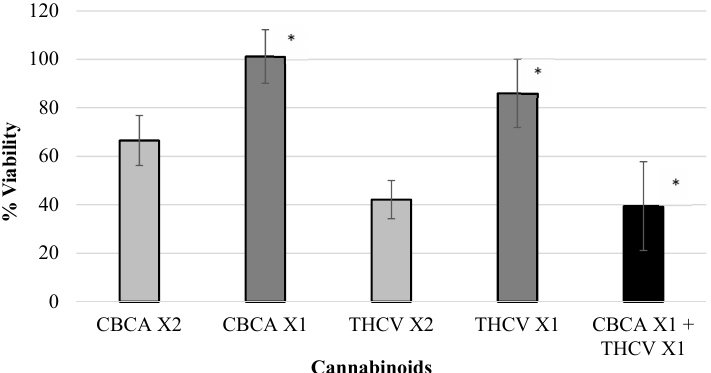
Figure 3. Viability of polyp cells exposed to CBCA and THCV. Combinations between CBCA (at X2 concentration—29 µM or X1 concentration—14.5 µM) and THCV (at X2 concentration—40/48 µM or X1 concentration—20/24 µM) significantly inhibited the viability of polyp-derived cells. The cannabinoid combination CBCA + THCV presented a synergistic effect (* p < 0.01, Bliss equation calculation = 0.48). Legend: cannabichromene acid (CBCA), tetrahydrocannabivarin (THCV).